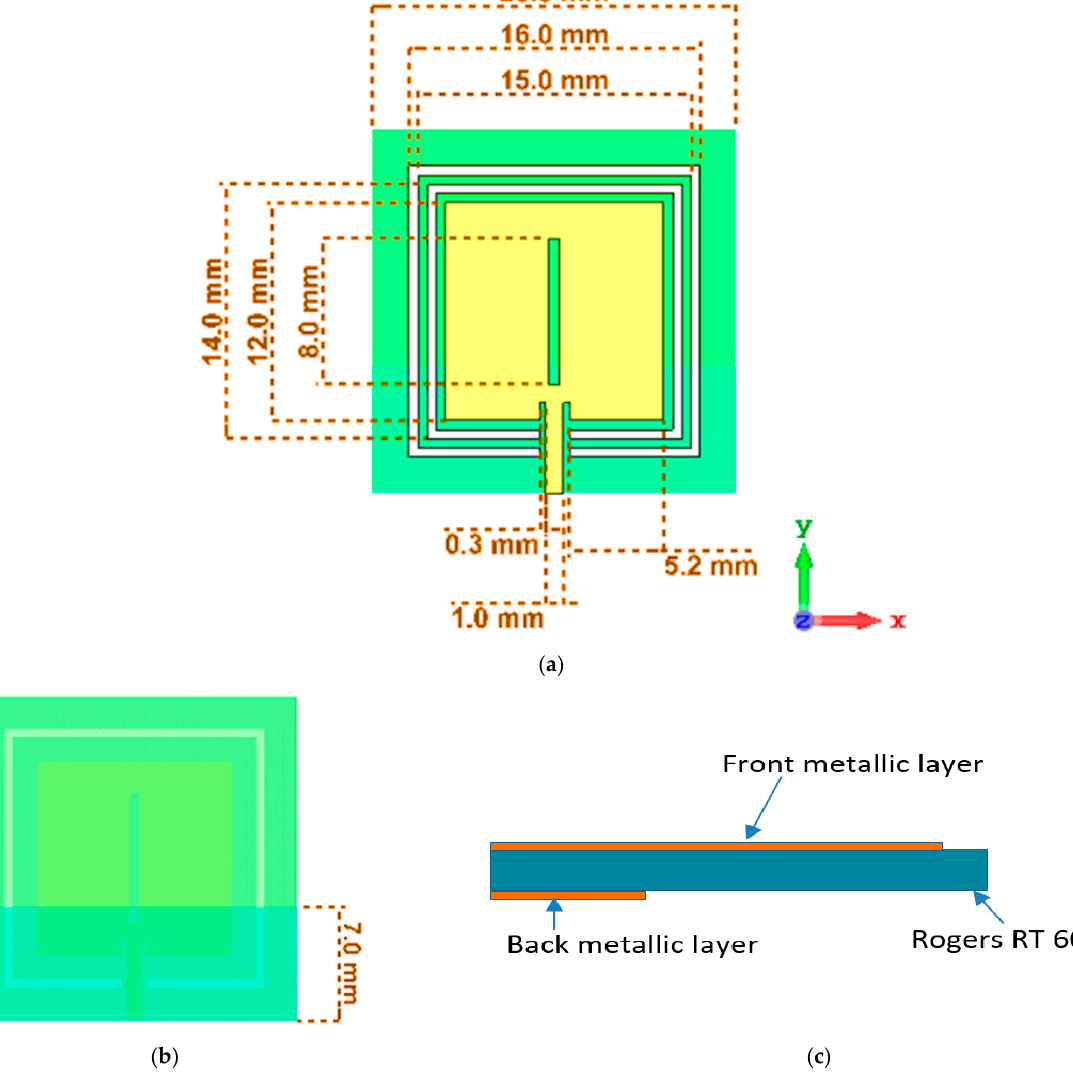
Table 1. The parametric specification for the proposed microstrip-based sensor.